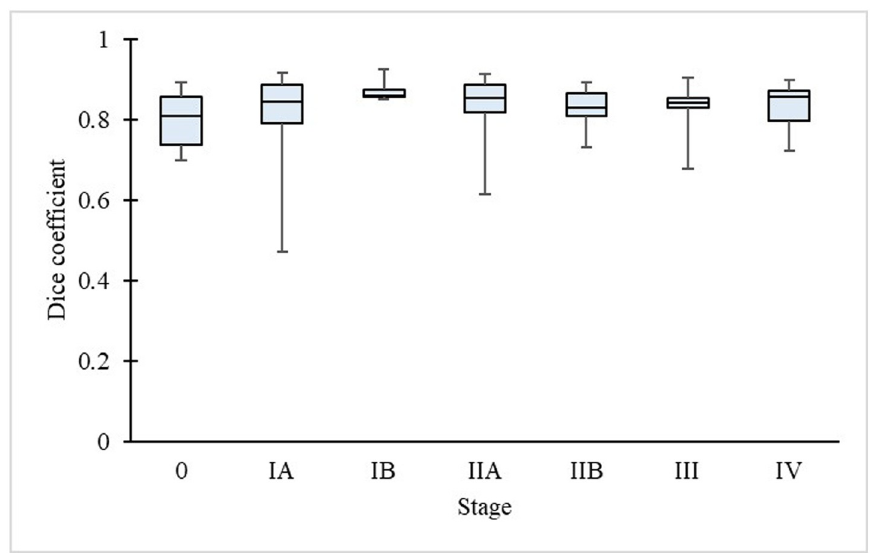
Fig 6. Stage of disease and Dice coefficient of the